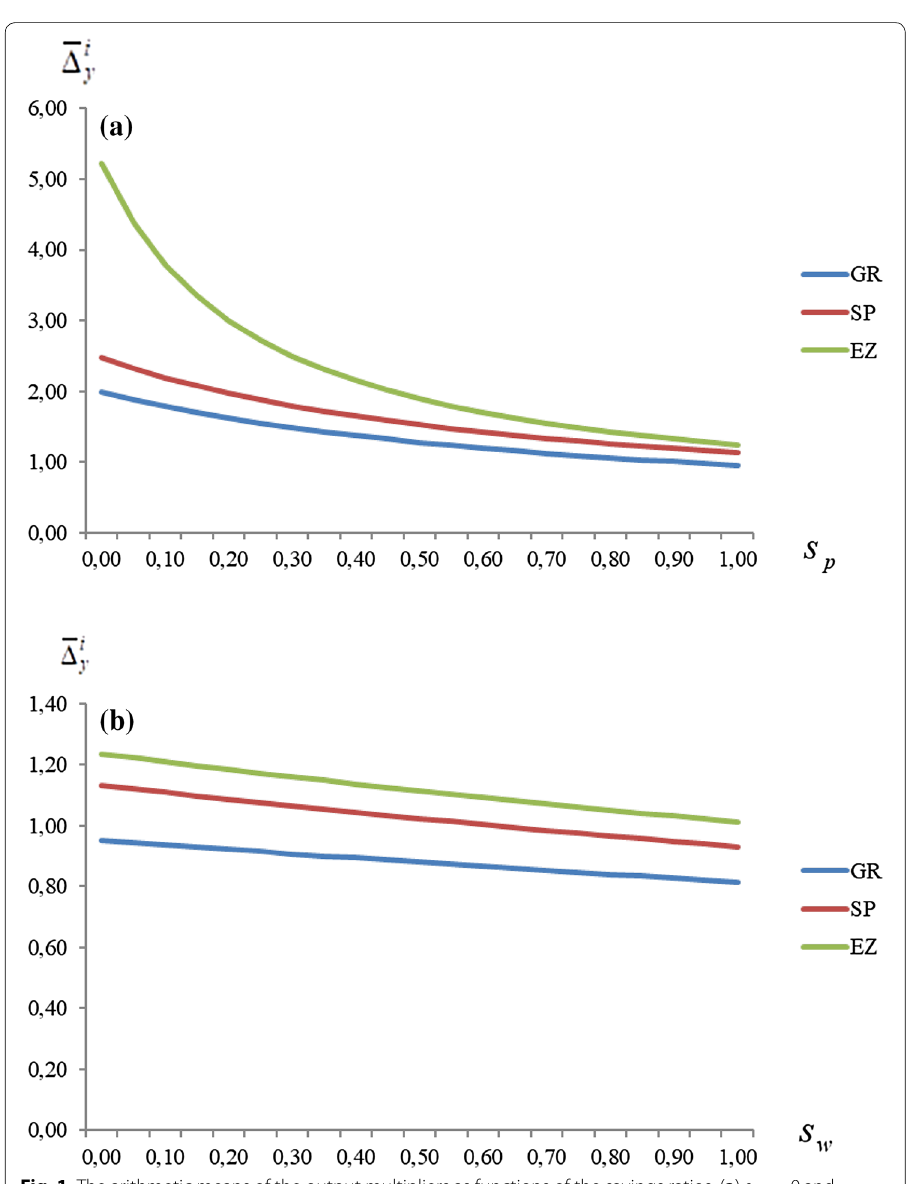
Fig. 1 The arithmetic means of the output multipliers as functions of the savings ratios: ( a ) s w = 0 and 0 ≤ s p ≤ 1 ; ( b ) 0 ≤ s w ≤ 1 and s p =